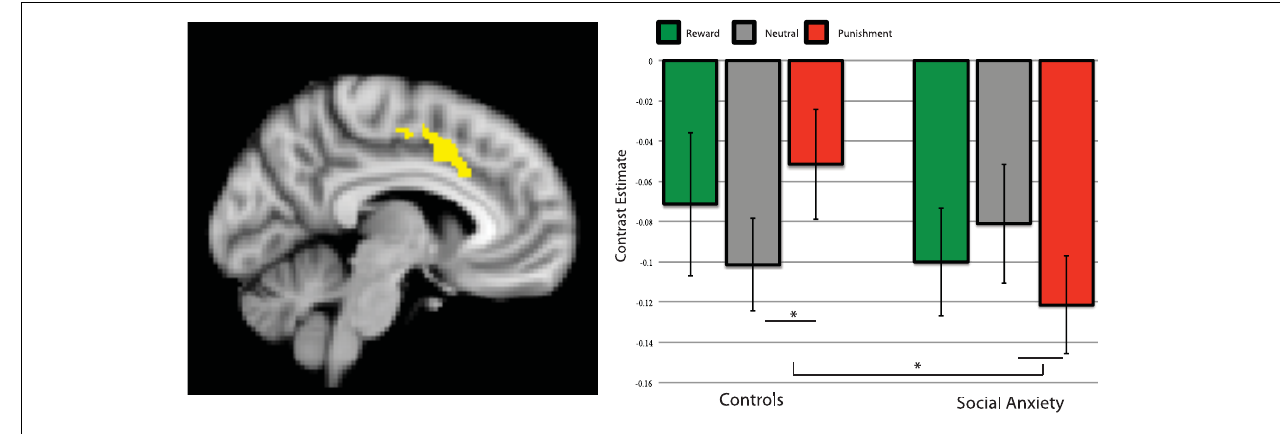
FIGURE 3 | Brain connectivity between left putamen and dACC during the anticipation of reward, neutral and punishment trials. Parameter estimates per group and condition compared to